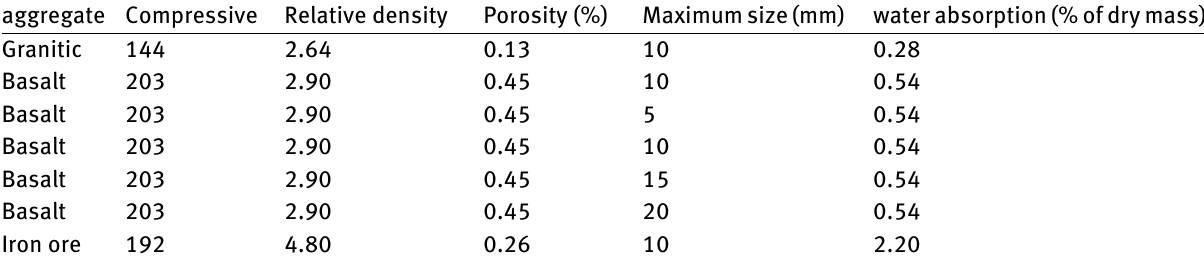
Table 2: Properties of coarse aggregates aggregate Compressive Relative density